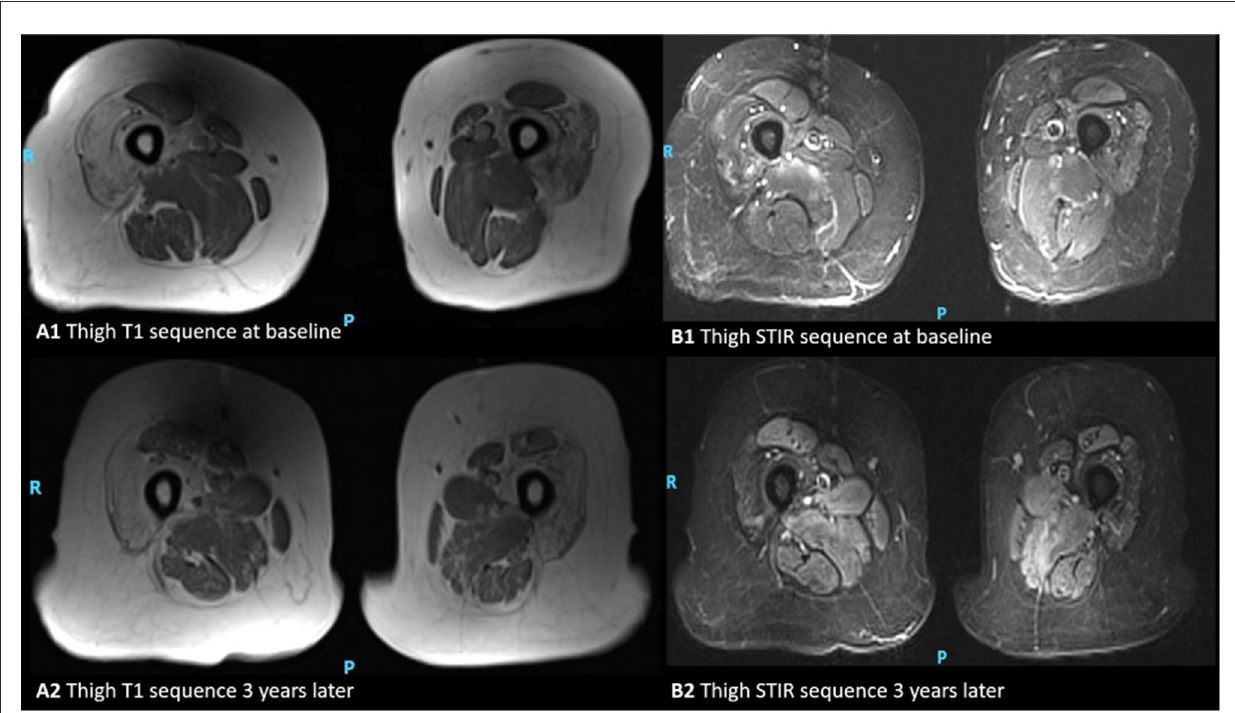
FIGURE3 MRI appearances of thigh muscles in a patient with inclusion body myositis. Axial T1-weighted images of the thigh at the baseline and 3 years later (A1, A2) , and axial STIR respectively (B1, B2) . This figure illustrates progressive intramuscular fat accumulation with initial sparing of the rectus femoris as hyperintensities on T1-weighted sequence and acute muscle inflammation is evident as hyperintensity on STIR images (P, posterior; R, right).